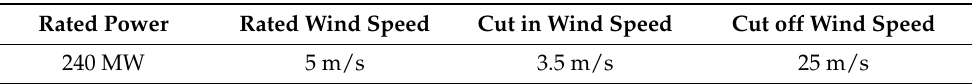
Table 6. Key specifications of the wind